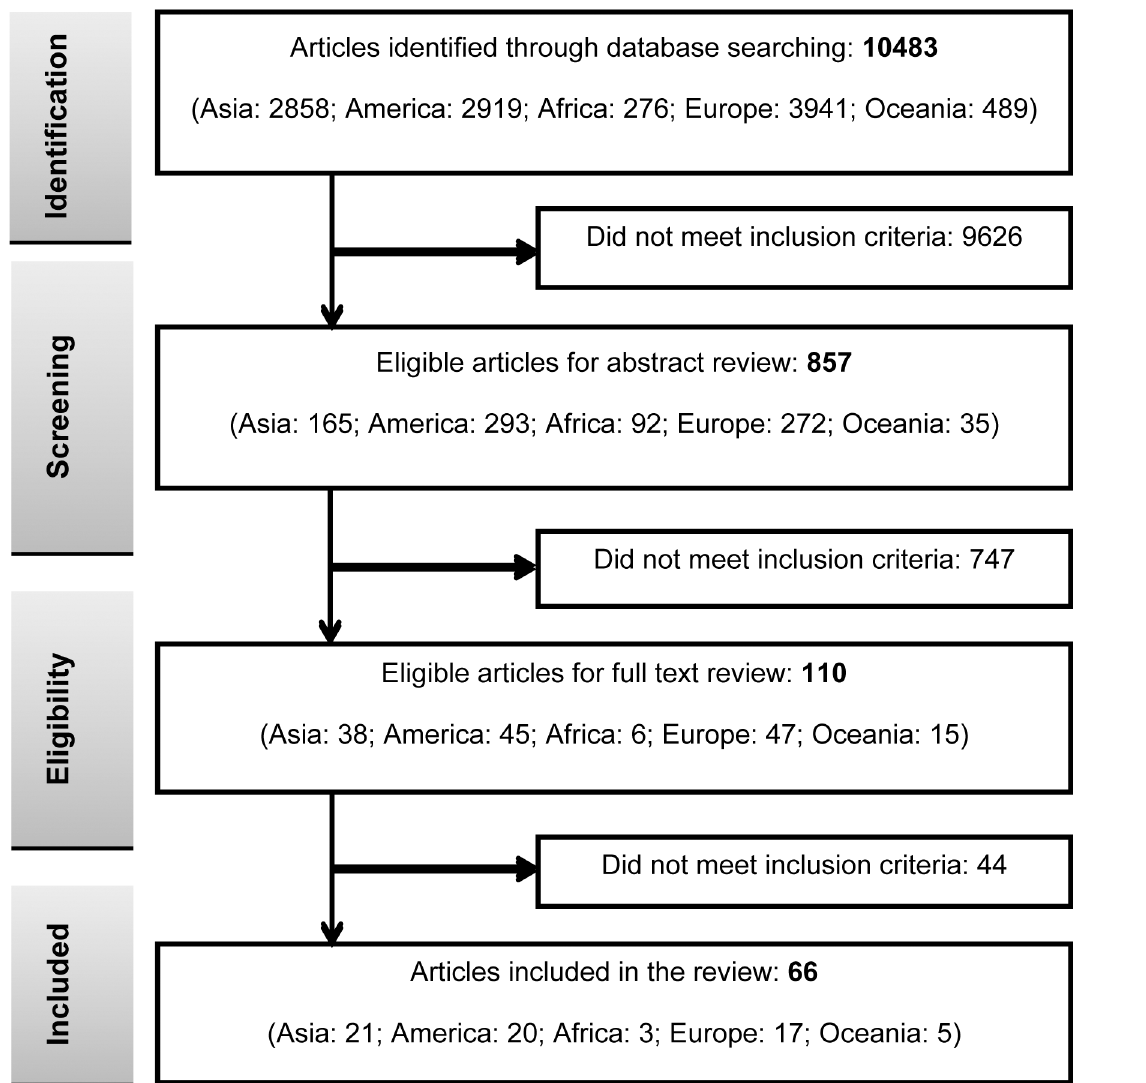
Fig 1. Literature search and